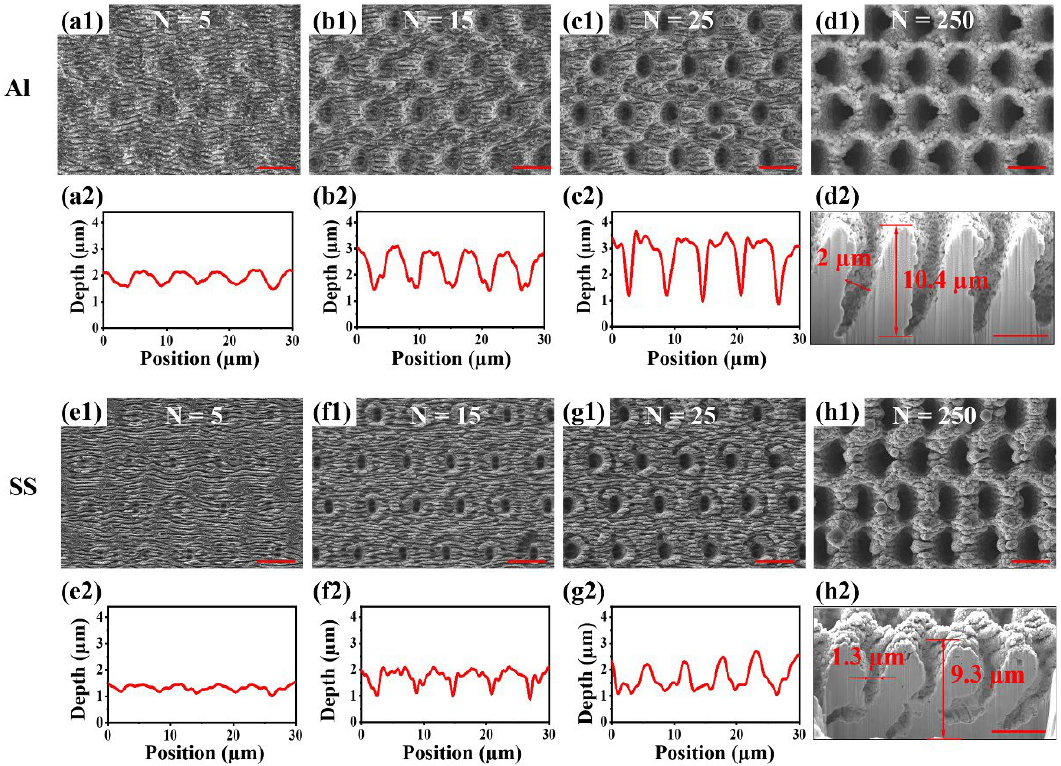
Figure 4. Surface morphologies of Al and SS after laser ablation. ( a1 – d1 ) Surface morphologies of Al under the action of burst Bessel beam with ( a1 ) N = 5, ( b1 ) N = 15, ( c1 ) N = 25, and ( d1 ) N = 250. ( a2 – c2 ) Laser confocal microscopy of LIPSS–pit structure in ( a1 – c1 ). ( d2 ) The cross-section morphol- ogy of SEM in ( d1 ). ( e1 – h1 ) Surface morphologies of SS under the action of burst Bessel beam with ( e1 ) N = 5, ( f1 ) N = 15, ( g1 ) N = 25, and ( h1 ) N = 250. ( e2 – g2 ) Laser confocal microscopy of LIPSS–pit